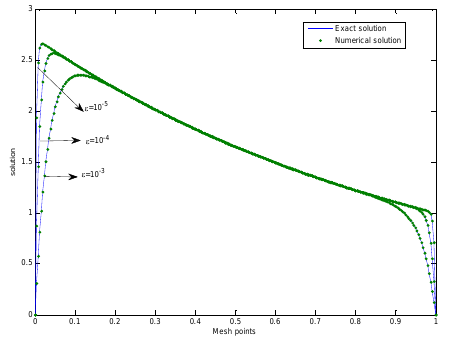
Fig 3. Graphical representation of solution in Example 3